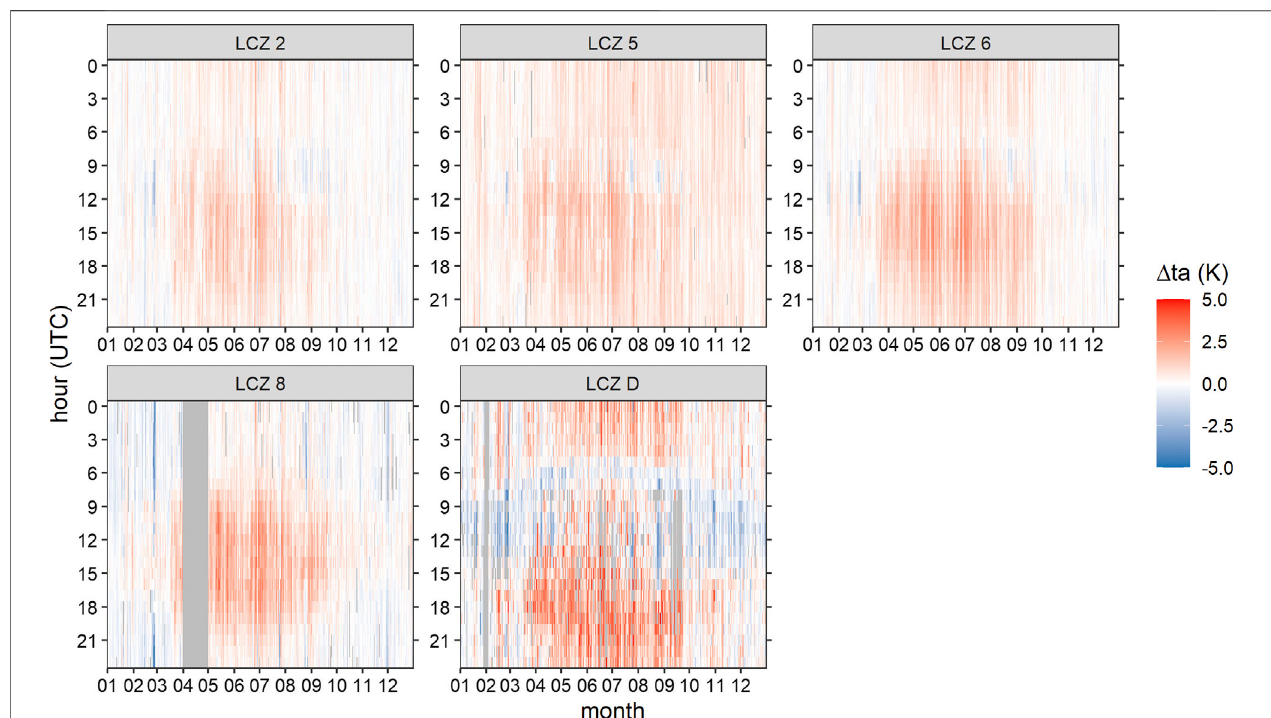
FIGURE4| Hourly air-temperaturedifference( Δ ta )betweenmeanCWSandmeanPRWS ta inAmsterdam perLocalClimateZoneLCZ during2019.CWSdataat QC level m5 after CrowdQC+ with default settings (cf. Table 2 ). CWS and PRWS data were averaged across all stations in the respective LCZ. Missing episodes are displayed in